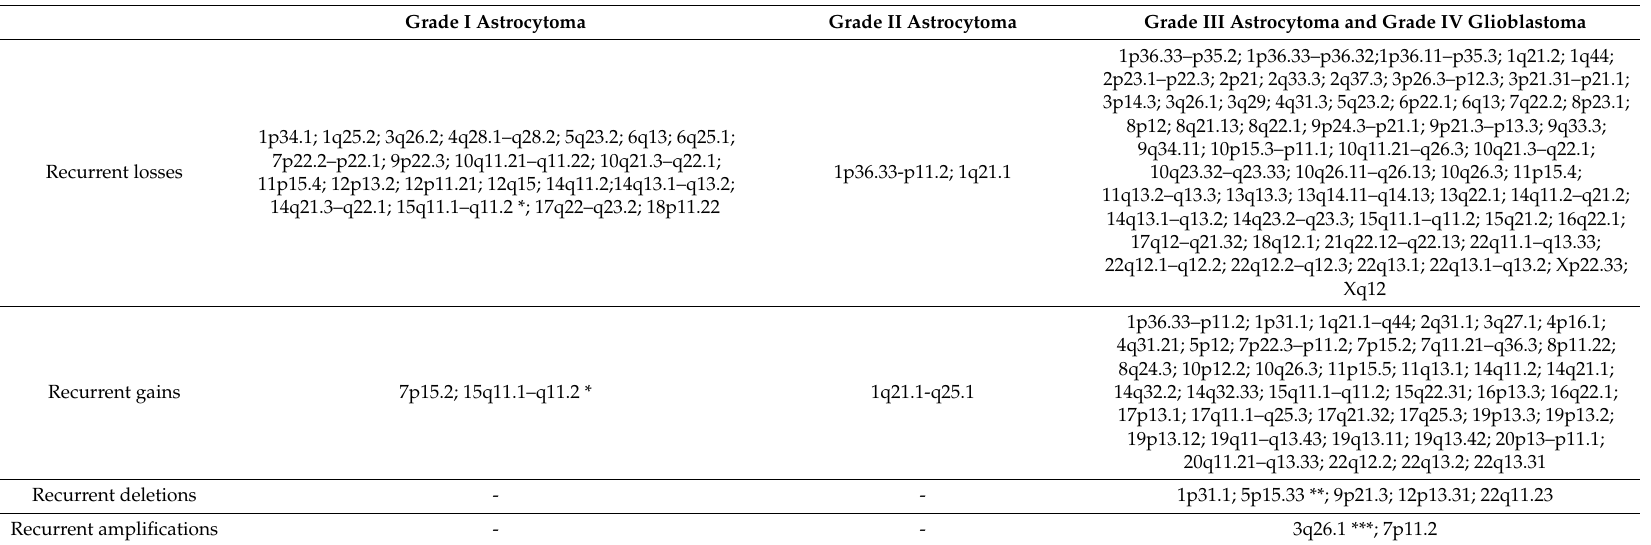
Table 2. Aberrant regions shared between astrocytomas of the same malignancy